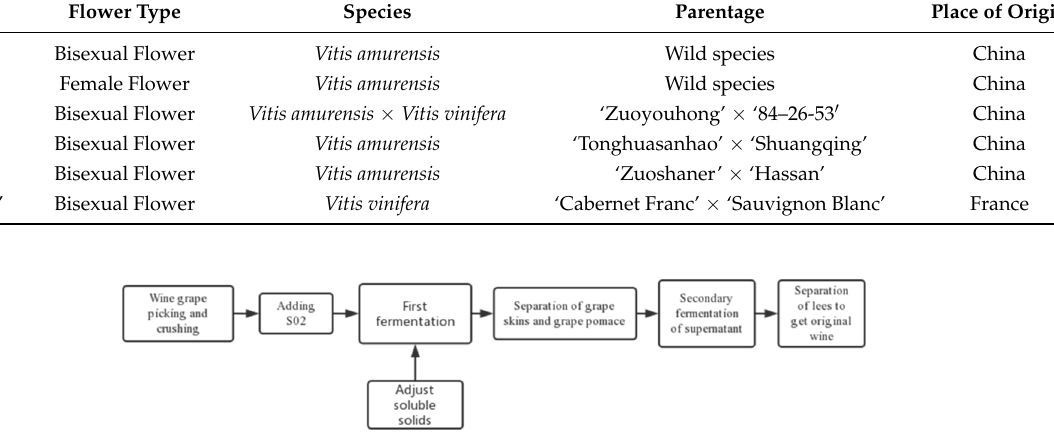
Figure 1. Fermentation experiment flow chart. Table 1. Materials used in this study.